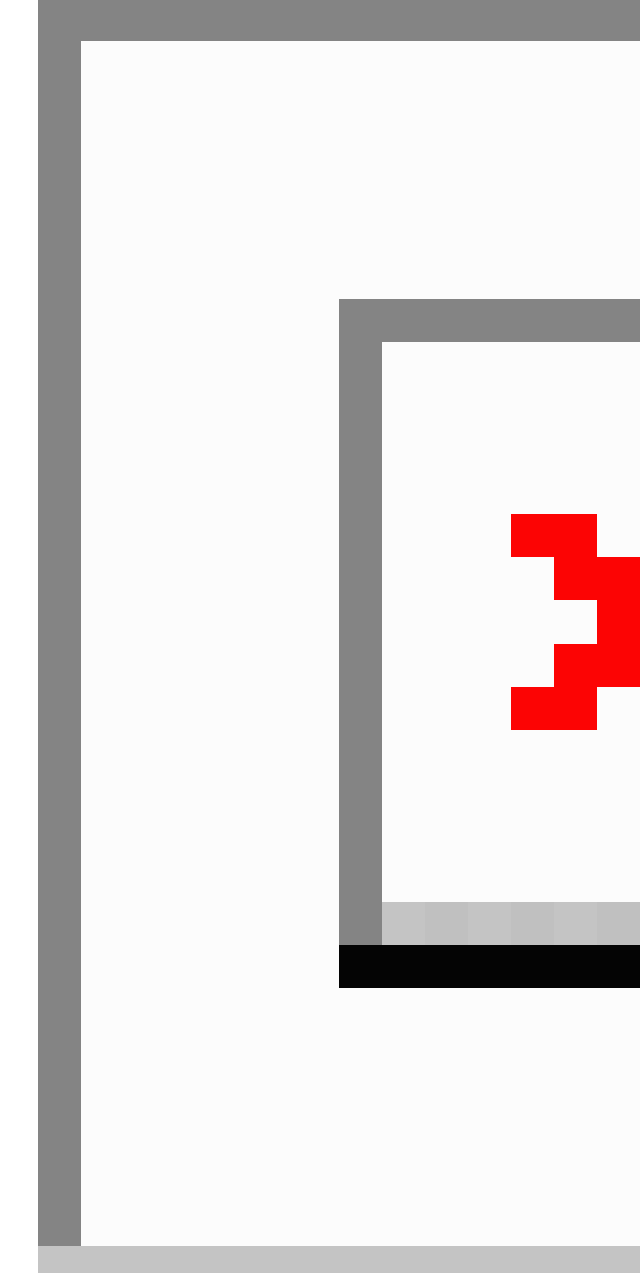
Figure 1. Flowchart of enrollment in phase I and phase